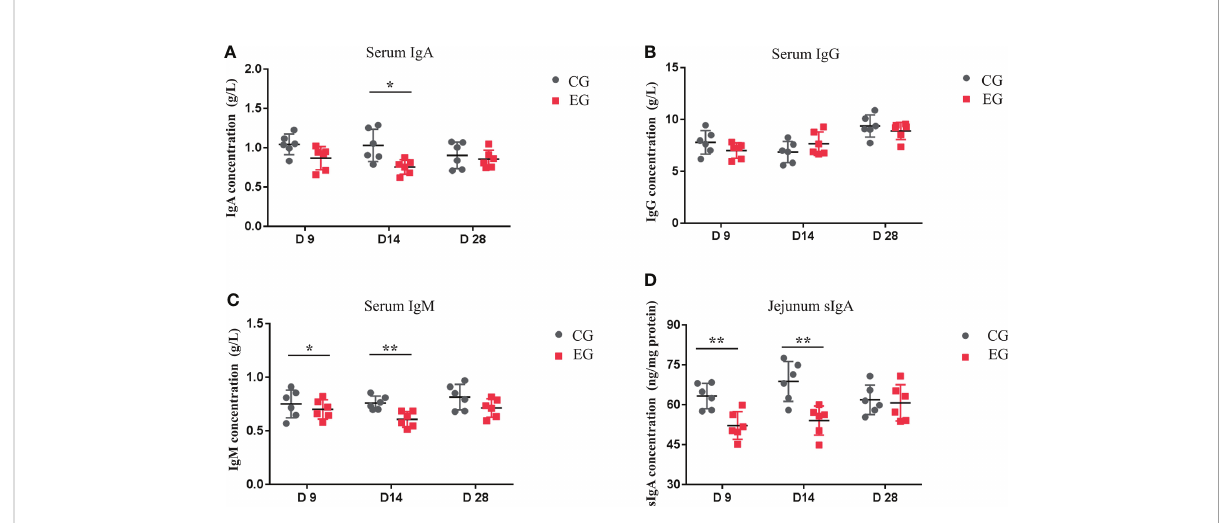
FIGURE 3 Effect of the Escherichia coli challenge on immune factors in the serum and intestine of the ducks. CG, control group (non-challenged with pathogenic ( E ) coli O88); EG, experiment group (challenged with pathogenic ( E ) coli O88). (A) Serum IgA, immunoglobulin A; (B) serum IgG, immunoglobulin G; (C) serum IgM, immunoglobulin M; (D) jejunum sIgA, secretory immunoglobulin (A) Data are indicated as means ± SEM ( n = 6), * 0.01 < P < 0.05; ** P <